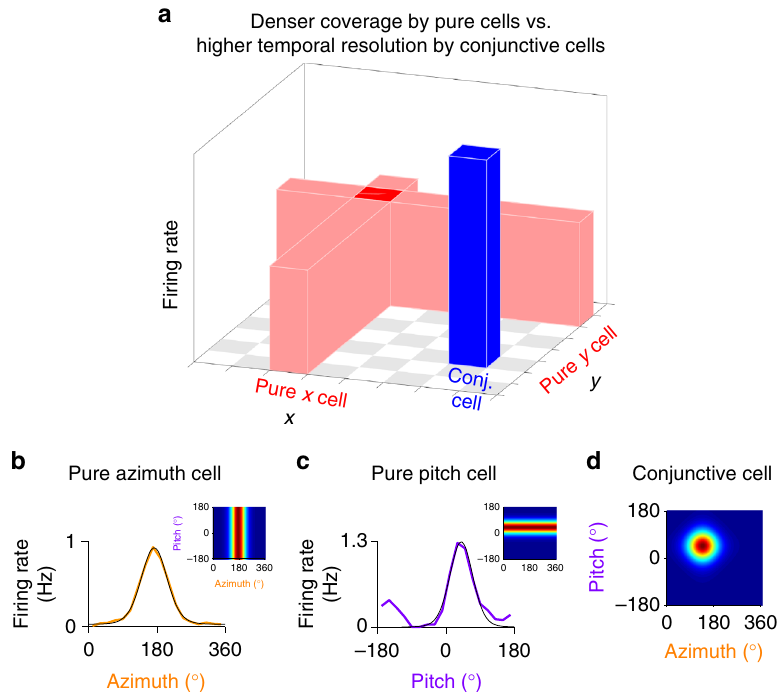
Fig. 1 Head-direction coding by mixed-dimensionality neurons in the bat brain. a Schematic illustrating that a multidimensional stimulus (e.g., a 2D stimulus), can be represented with sub-populations of pure cells that are tuned to only one dimension of the stimulus, or by a population of conjunctive cells that encode the different dimensions of the stimulus jointly. Because pure cells have larger receptive fi elds they can tile the stimulus space more densely, compared to a population comprising the same number of conjunctive cells. Therefore, when naively considering a two-dimensional variable such as a position of a rook on a chessboard, one would expect to need only 2 × N pure cells ( N cells encoding the X dimension and N cells encoding the Y dimension) in order to reach the same representational accuracy as N × N conjunctive cells (with X × Y tuning). However, conjunctive cells provide information about both dimensions of the stimulus at the same time, whereas decoding the activity of pure cells requires co- fi ring of both pure X and pure Y cells, and thus can be compromised at short decoding times. b , c Examples of 1D tuning curves of head-direction cells that we recorded in the bat dorsal presubiculum 19 : a pure azimuth cell ( b ) and a pure pitch cell ( c ), overlaid with von-Mises fi ts (black). Top insets in b and c illustrates schematically the directional tuning of these pure cells in the 2D space of solid angles (360° azimuth × 360° pitch). d An illustration of a conjunctive cell with 2D tuning to a speci fi c combination of azimuth × pitch angles. The existence of both pure and conjunctive neurons in the same brain region suggests a mixed-dimensionality